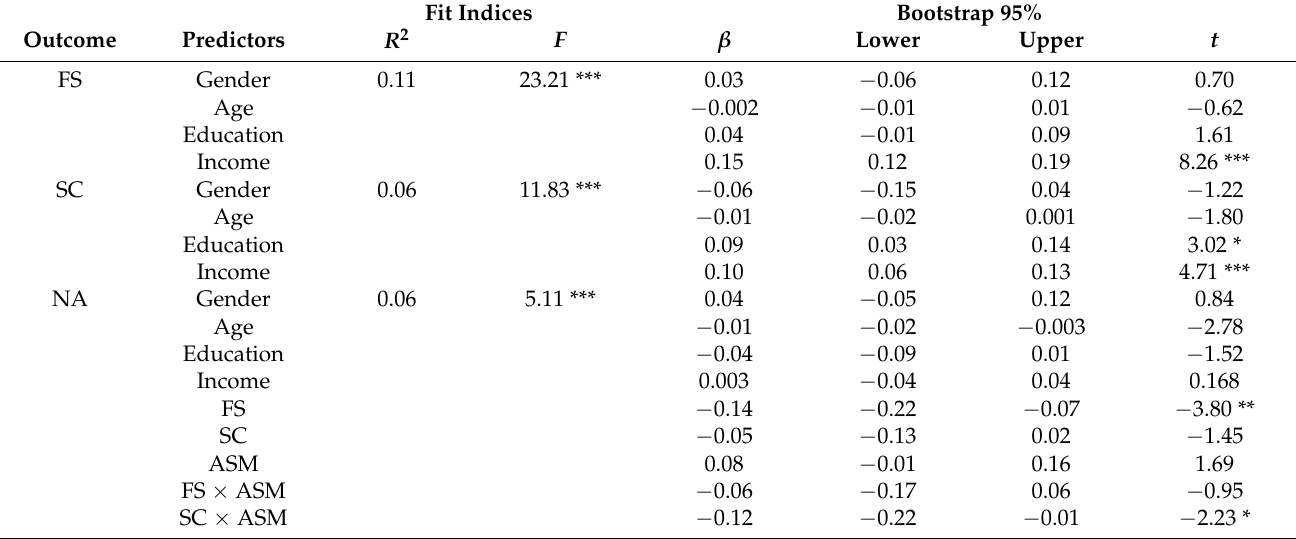
Table 10. Testing the moderated mediation effects for Negative Affect in study